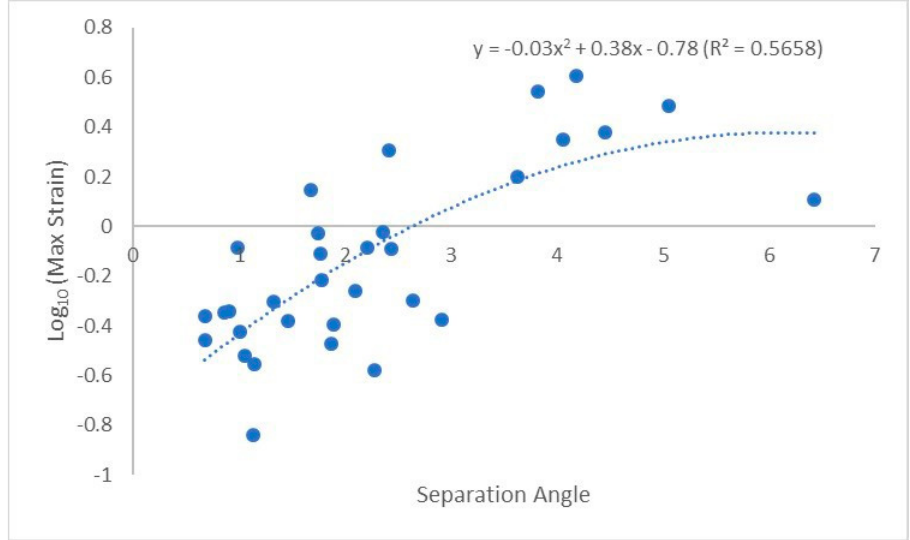
Figure 5. Polynomial best fit line between Log 10 (MaxStrain) and separation angle.